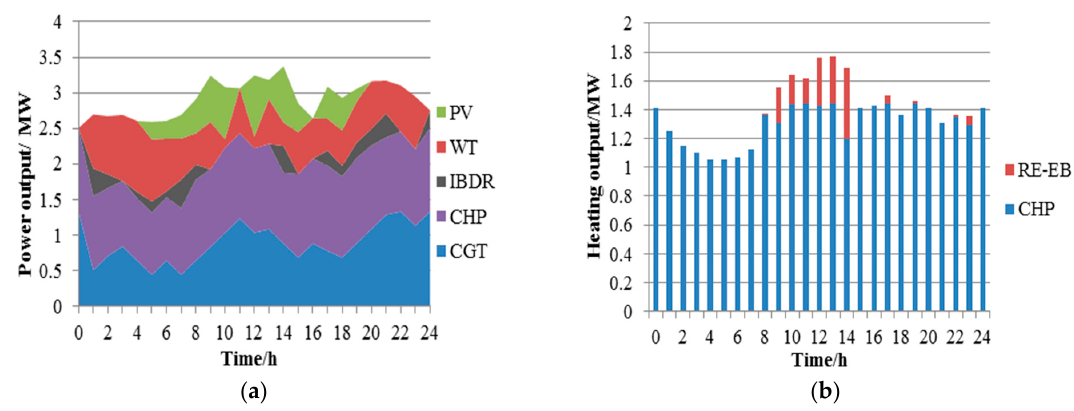
Figure 10. The results of HES operation after application of PBDR ( a ) and RE-HS ( b ) in Case 2 .